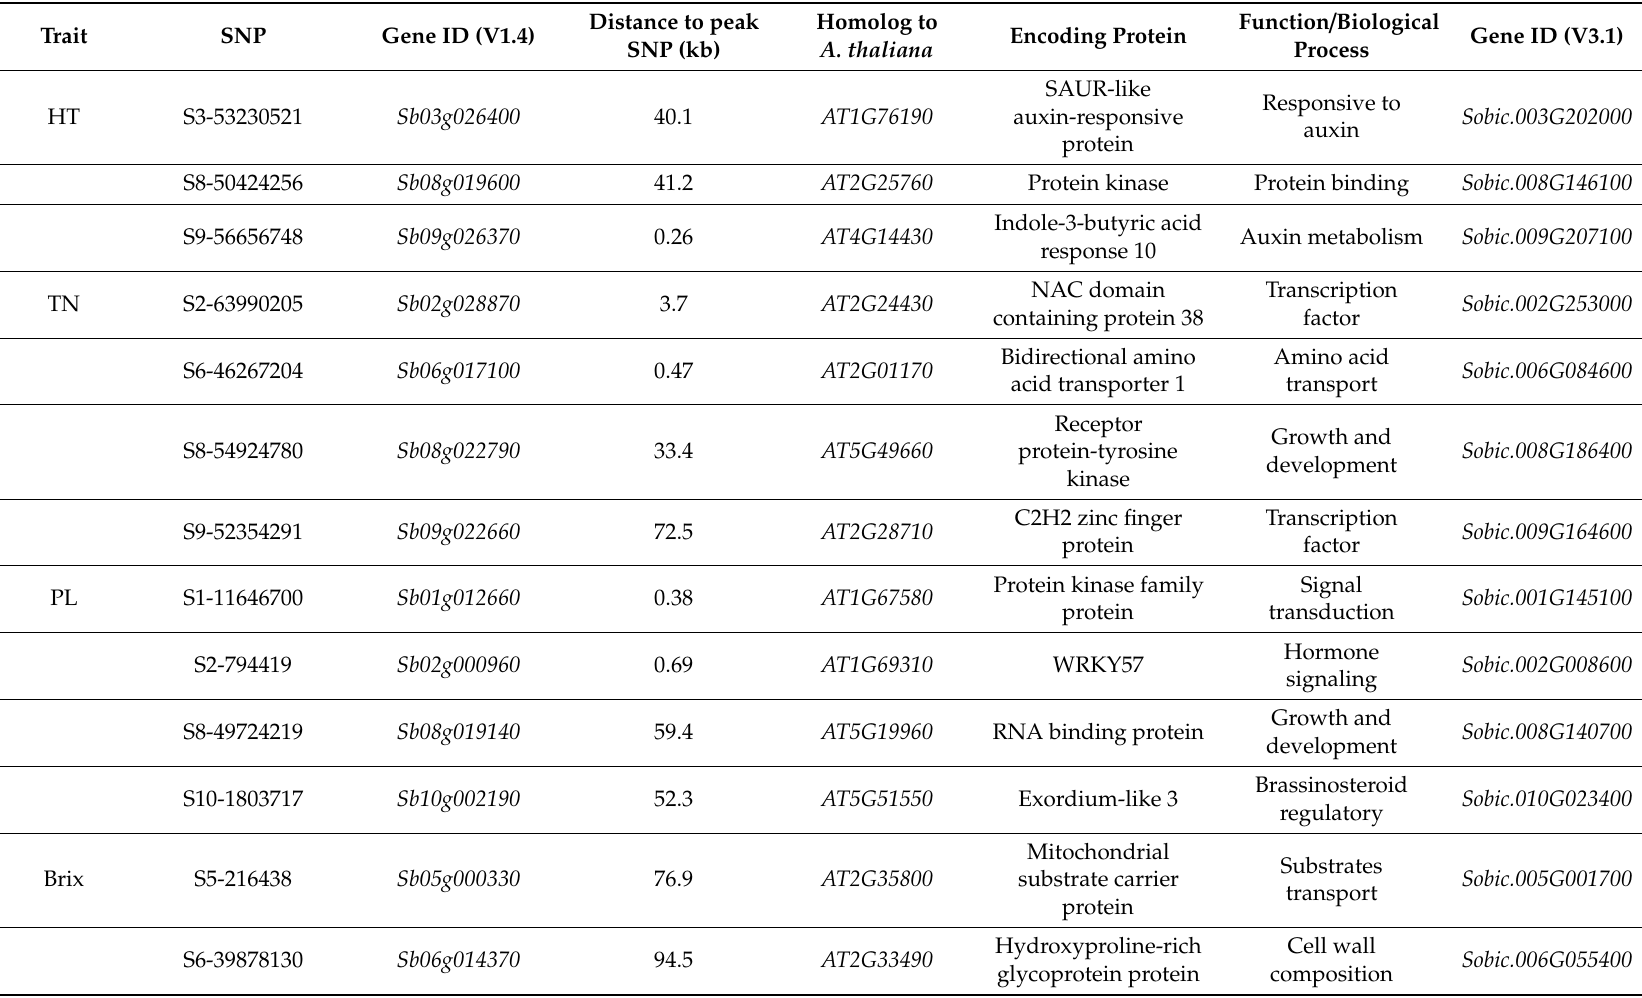
Table 5. The potential candidate genes identified corresponding to the significant single nucleotide polymorphism (SNP) associated with traits of plant height (HT), tiller number (TN), panicle length (PL), Brix, and reducing sugar (RS) in the population across three